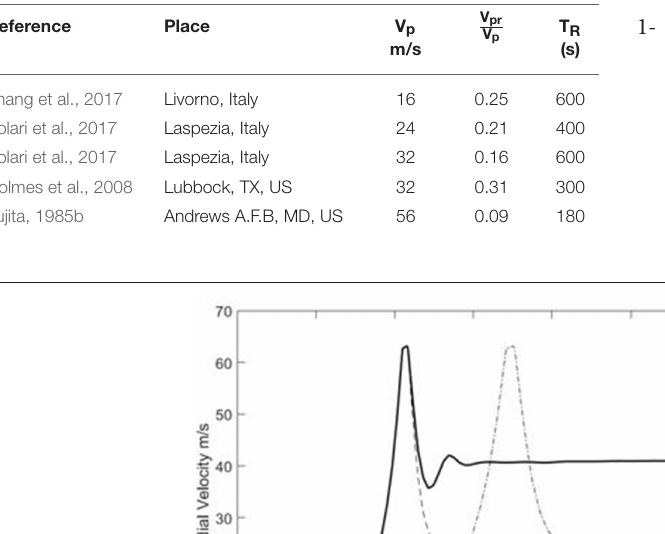
TABLE 2 | Comparison of downburst characteristics from different studies.